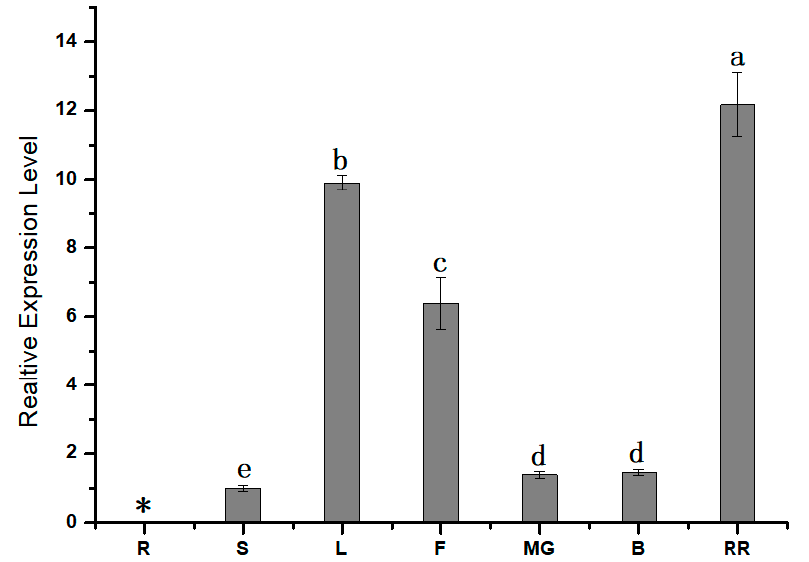
Figure 2. Expression pattern analysis of SlPG49 by qRT-PCR. R: roots; S: stems; L: leaves; F: flowers;